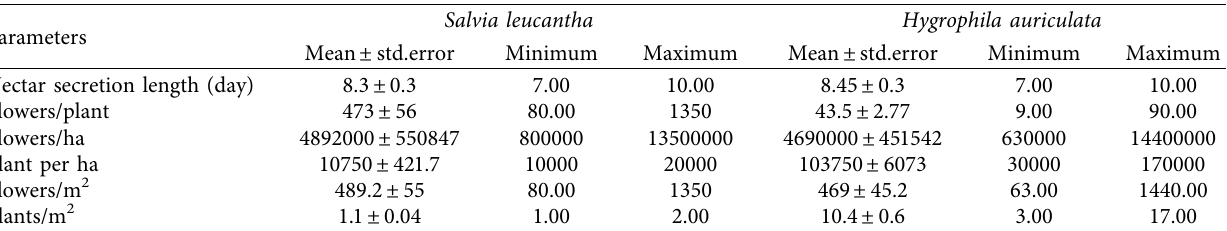
Table 1: Mean nectar secretion length (day), fowers/plant, fowers/ha, plant/ha, fowers/m 2 , and plants/m 2 of S. leucantha and H. auriculata .